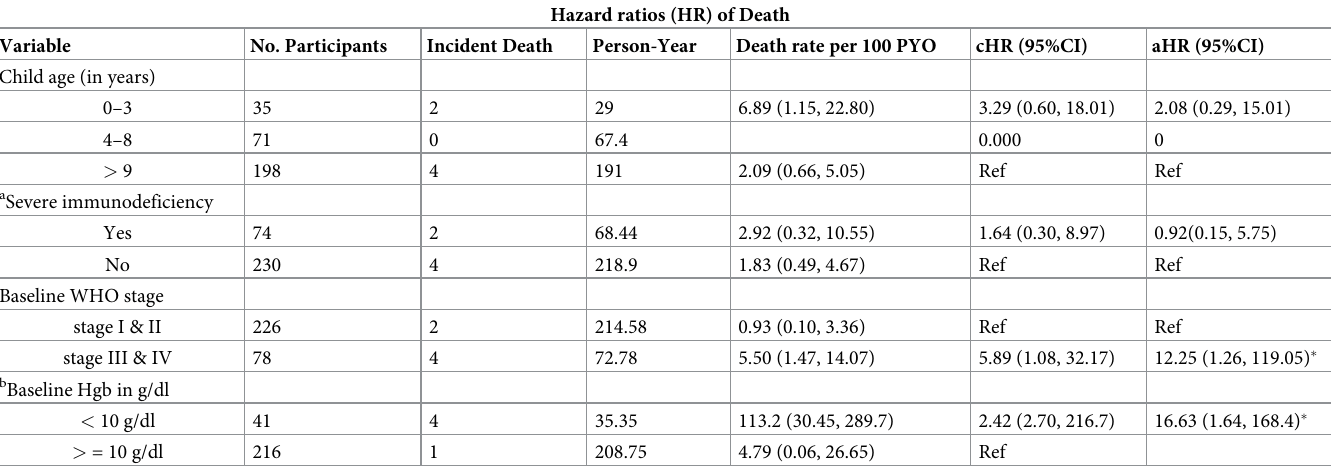
Table 4. Hazard ratios (HR) of Death according to Cox regression analyses, Ethiopia,